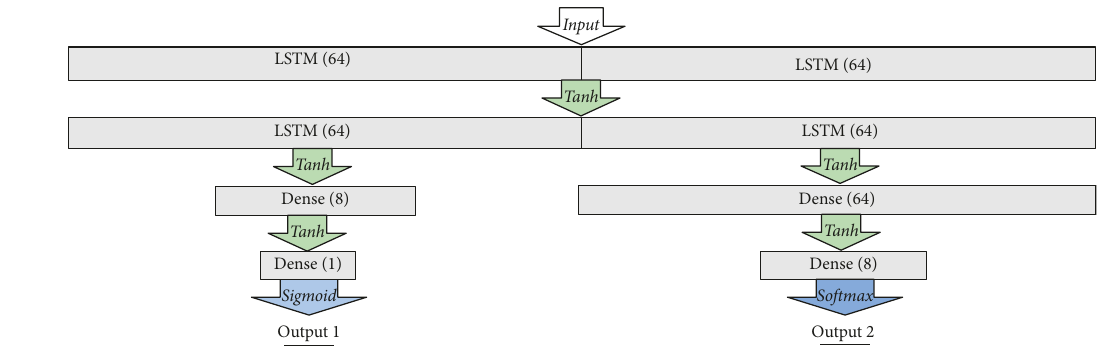
Figure 2: The architecture of the deep learning